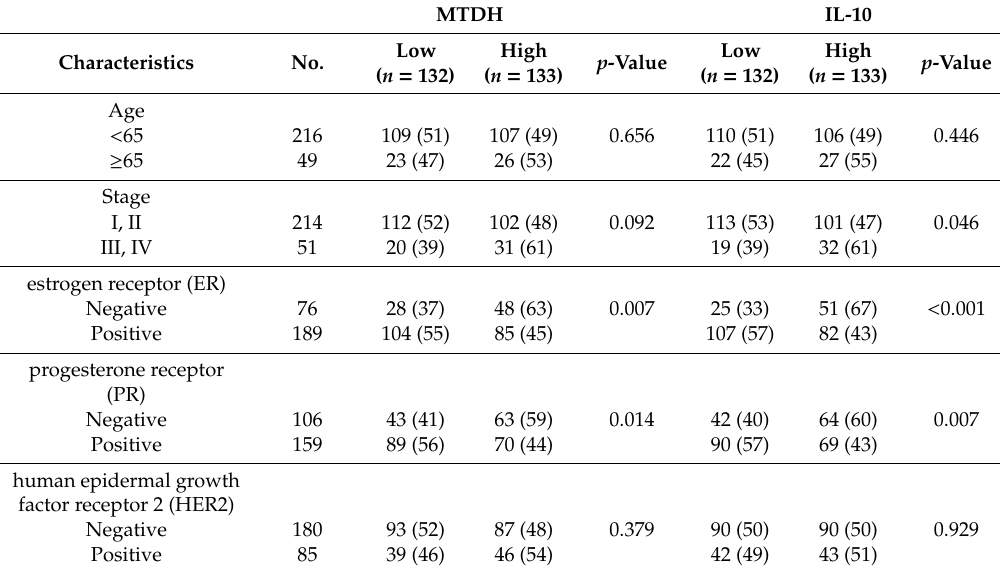
Table 1. Relationship of Clinical Parameters with MTDH and IL-10 protein expression in 265 breast cancer. Characteristics No.